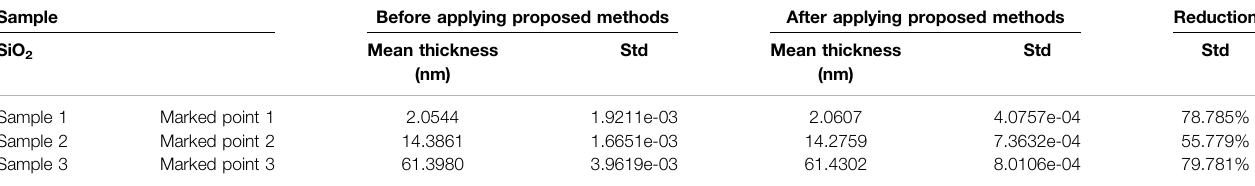
TABLE 1 | Results of fi lm thickness measurements. Sample Before applying proposed methods After applying proposed